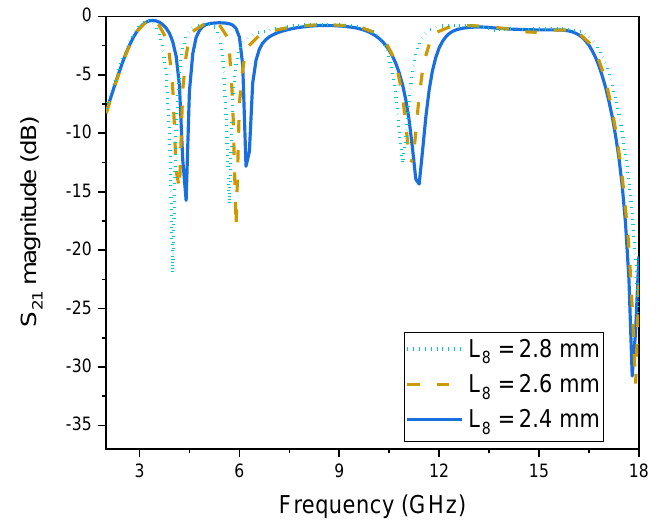
Figure 16. Validation of third band control w.r.t L 6 .